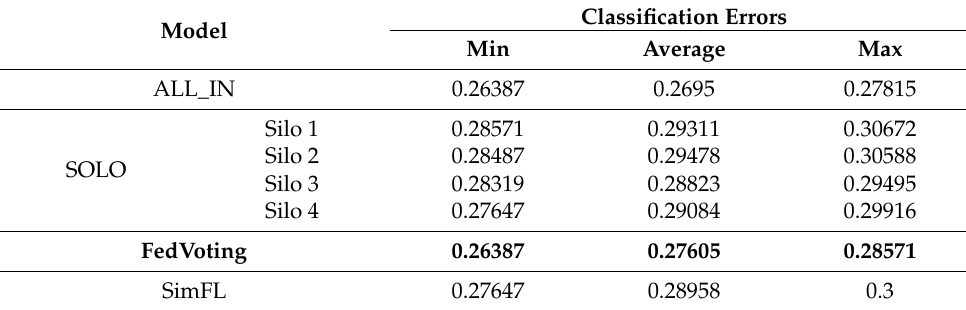
Table 3. The comparison of classification errors in Comiket attendance prediction. Model